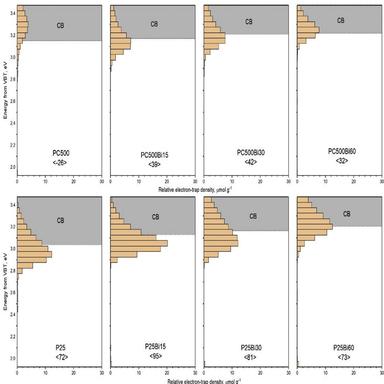
ERDT/CBB patterns of coated and uncoated titania powders. Figures in b N represent total density of electron traps in μmol g−1 .